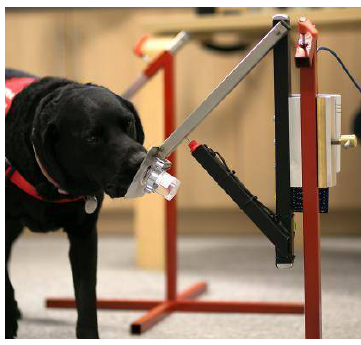
Figure 6. Olfaction cancer detection system [41]. Photo courtesy of The Open University.